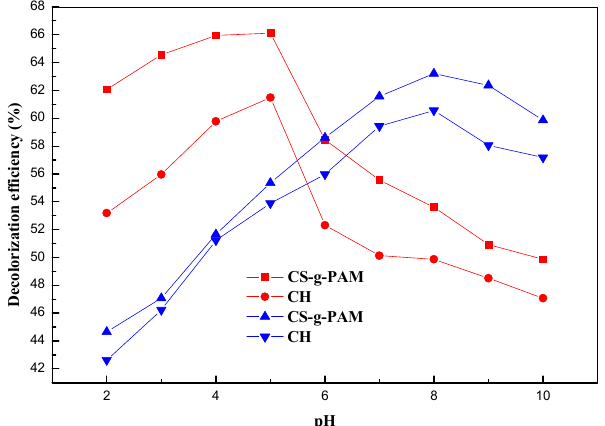
Figure 4. Effect of pH solution on the decolorization efficiency of MB and MO: initial MB/MO concentration: 8.0 mg/L; CS-g-PAM/CH concentration: 0.3 g·100 mL − 1 ; 25 °C.